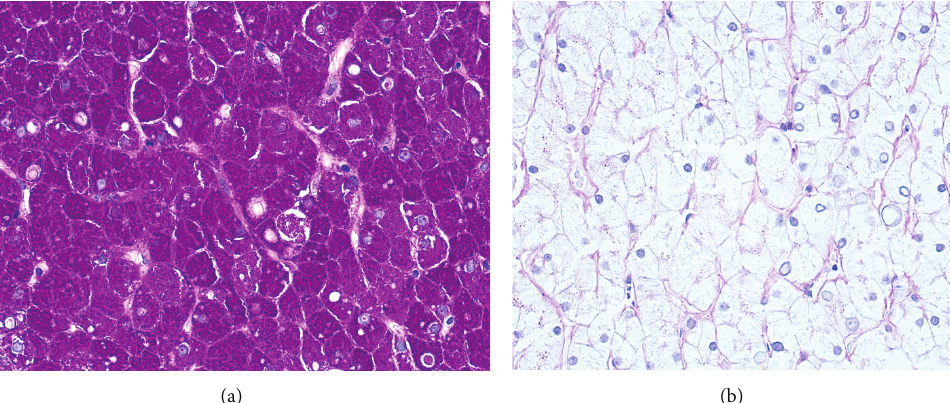
Figure 3: (a) Liver Biopsy. Periodic Acid-Schiff stain-positive for glycogen accumulation. (b) Glycogen abolishes after pretreatment with